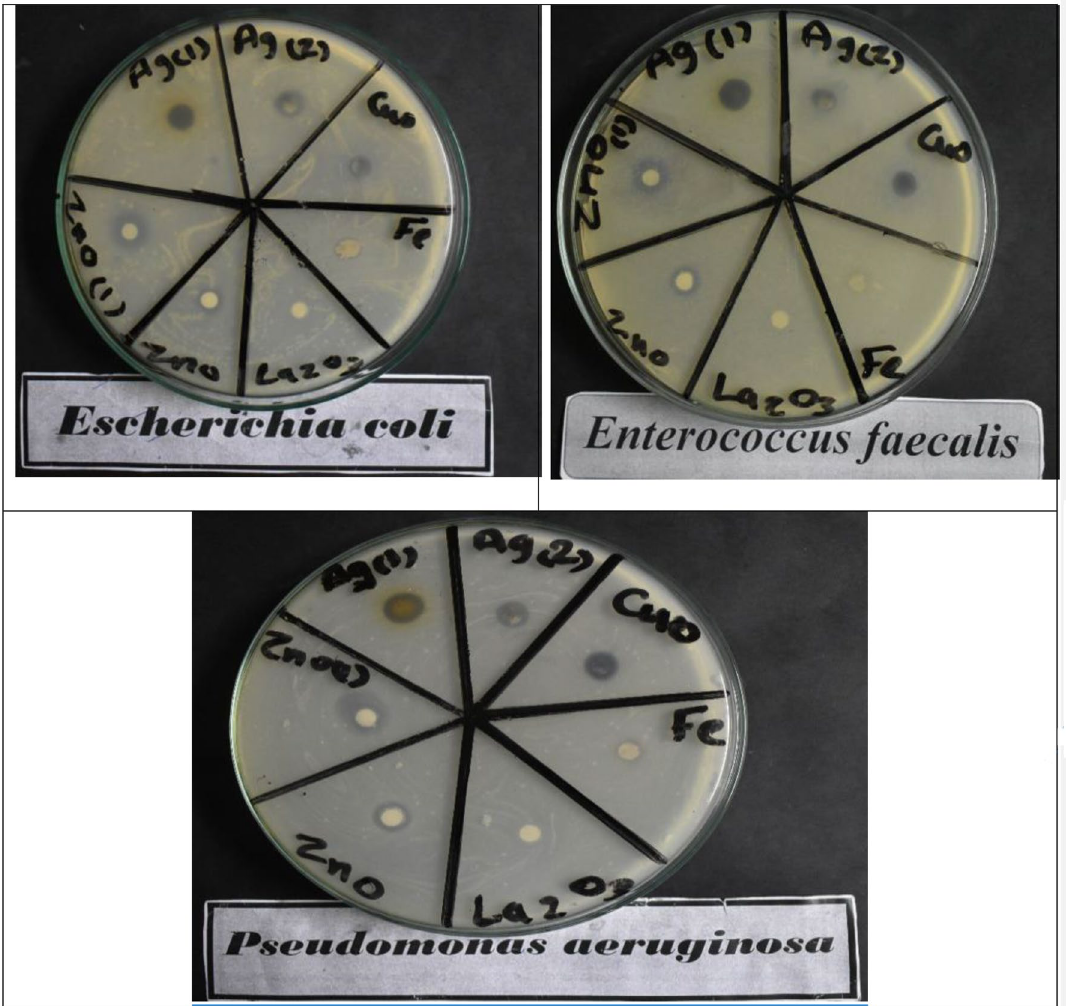
Figure 7. Antibacterial activity (Using Kirby‑Bauer Method ) of metal nanoparticles from aqueous extract of M.